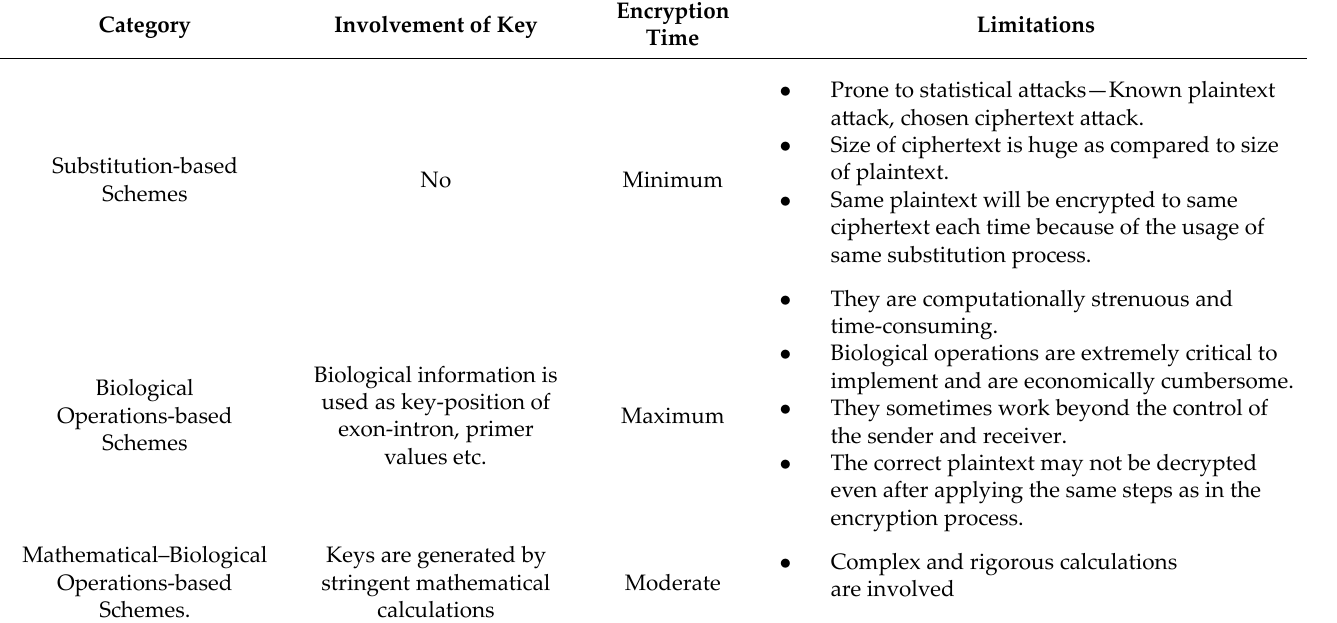
Table 2. Performance evaluation of existing DNA‑based Encryption